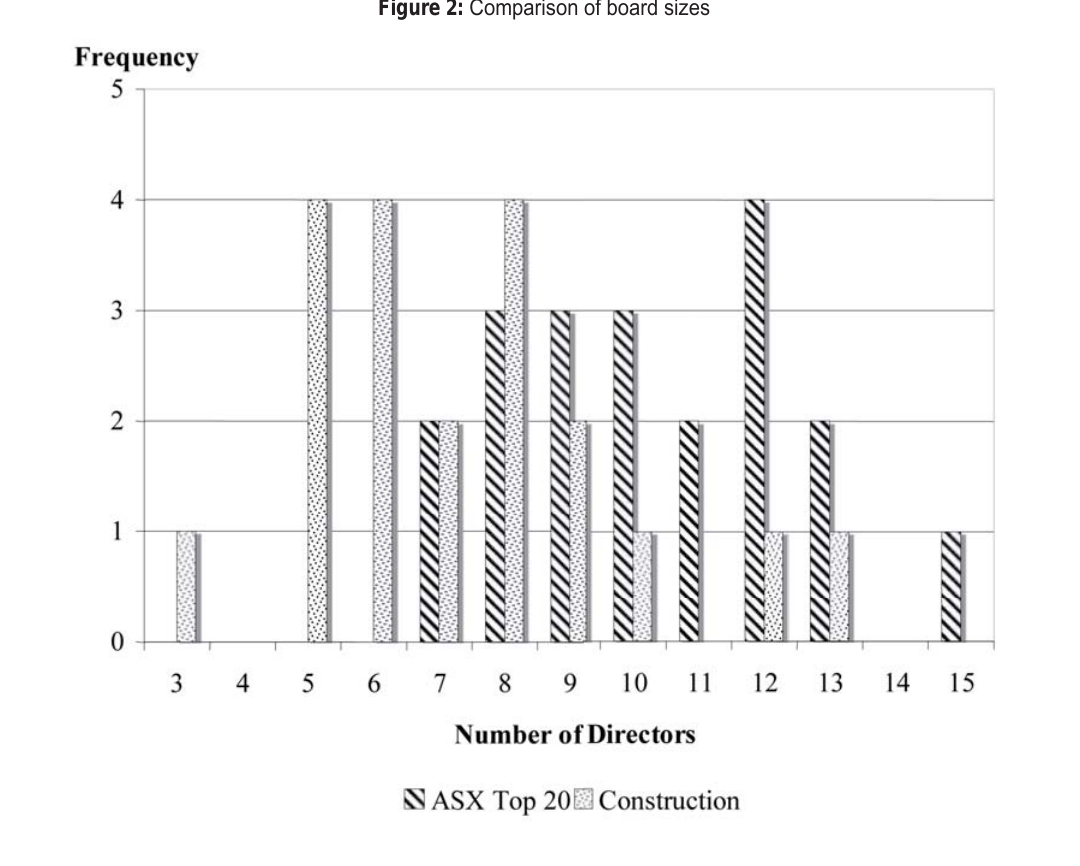
Figure 2: Comparison of board